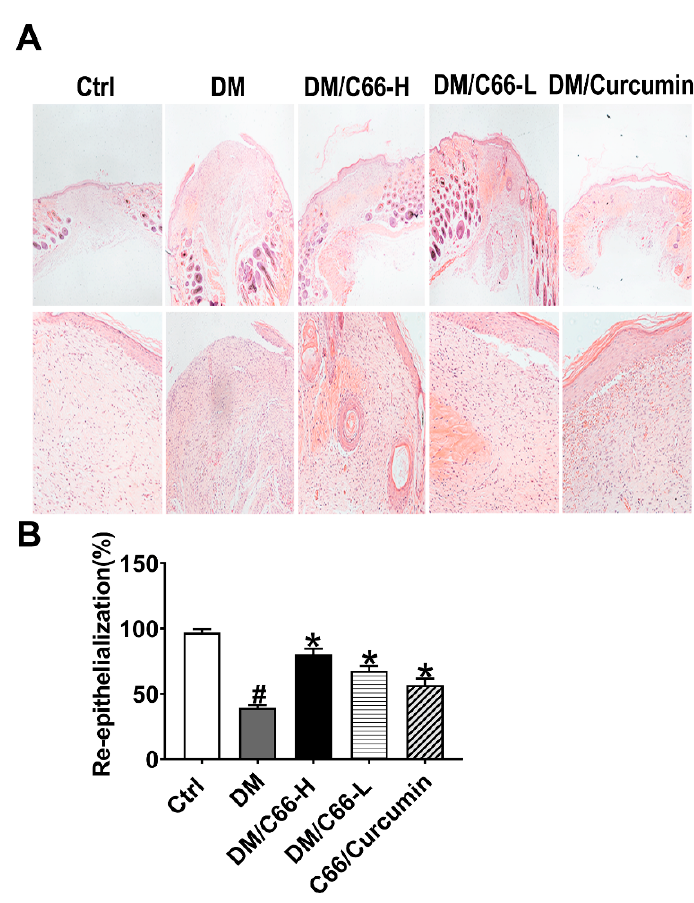
Figure 3. Reepithelialization of skin wounds was accelerated in the C66-treated mice. ( A ) Histological reepithelialization of skin wound in different groups were measured at day 14 after injury (H&E staining, ×100). ( B ) The ratio of reepithelialization was evaluated in different groups. Data are presented as the means ± S.D. ( n = 6 in each group). * p < 0.05 compared to the diabetes group value, # p < 0.05 compared to the control value. DM and Ctrl are short for the diabetic and control group, respectively.